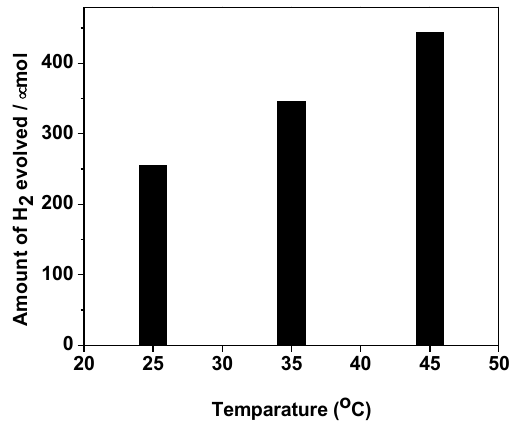
Figure 6. The effect of reaction temperature on photocatalytic hydrogen evolution activity over 1.5% CuO ‐ SrTiO 3 photocatalyst. Catalyst: 60 mg; amount of methanol: 60 mL, 60 vol.%; irradiation time: 2 h. It can be seen that the reaction temperature is a significant factor for the photocatalytic hydrogen evolution over the CuO ‐ SrTiO 3 photocatalyst from the methanol aqueous solution. The results in Figure 6 show that the photocatalytic activity for hydrogen evolution is increased when increasing the reaction temperature. The amount of hydrogen evolution can reach 444 μ mol at 45 °C, which is 1.75 times higher than that at 25 °C. According to